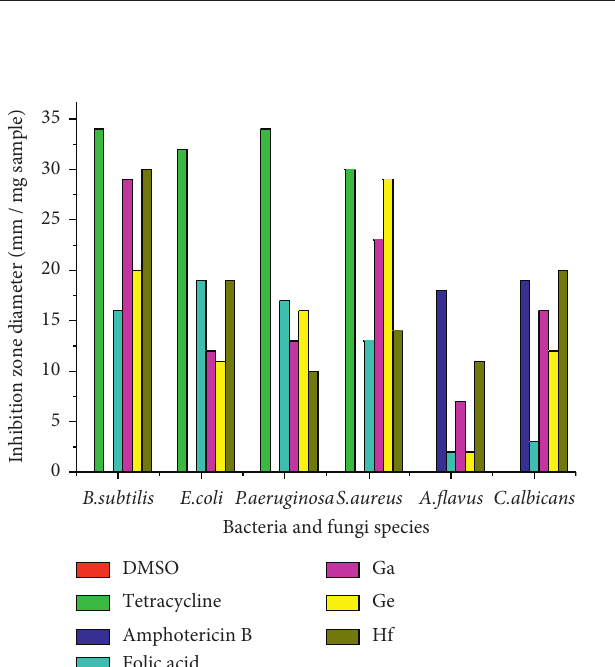
Figure 9: Inhibition zone diameter of DMSO control, “tetracycline” antibacterial agent, “amphotericin B” antifungal agent, and folic acid and its synthesized complexes against some bacteria and fungi species.